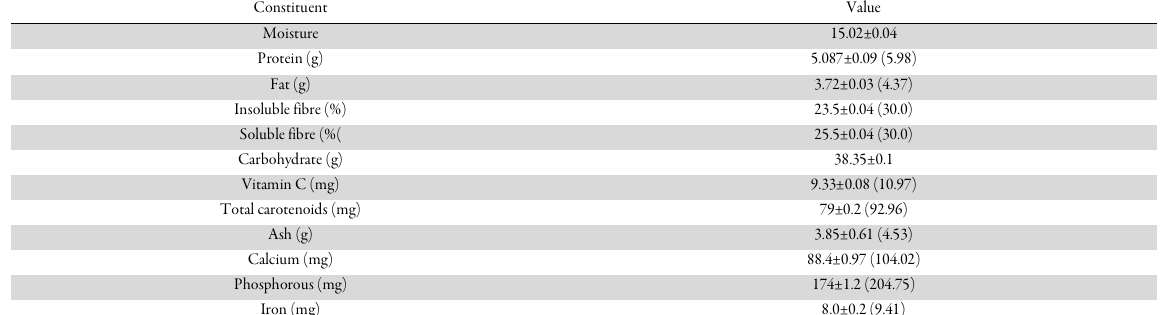
Table 2. Nutritional composition of Ginger (per 100 g) (Sandeep, 2017)